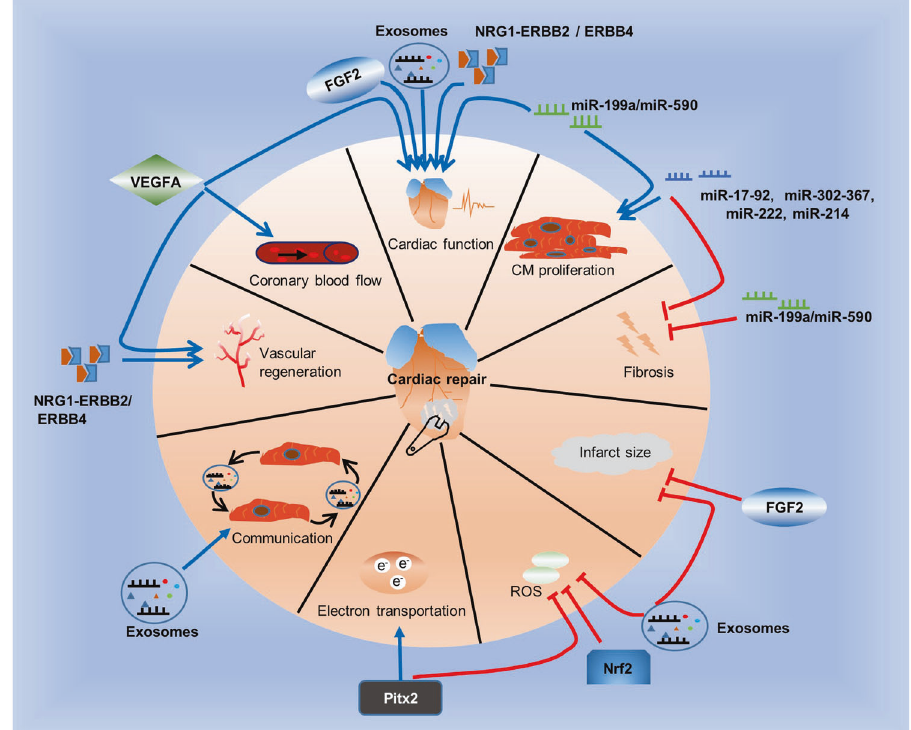
restore cardiac function. miR-199a or miR-590, the miR-17-92 cluster, miR-214, miR-302-367, and miR-222 induce CM proliferation. The miR-17- 92 cluster, miR-214, miR-302-367, miR-222 and miR-199a or miR-590 reduce fi brosis. FGF2 and exosomes reduce infarct size. Exosomes, Nrf2 and Pitx2 scavenge ROS. Pitx2 also regulates electron transport. Exosomes can act as mediators of cell-to-cell communication. NRG1 and its receptors ERBB2 and ERBB4 and VEGFA improve vascular regeneration. VEGFA also improves local coronary blood fl